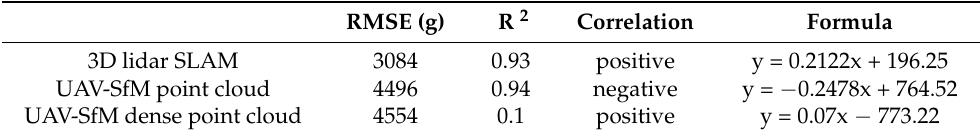
Table 4. Relationship between fresh weight and estimated volume value in different blocks at the experimental site.